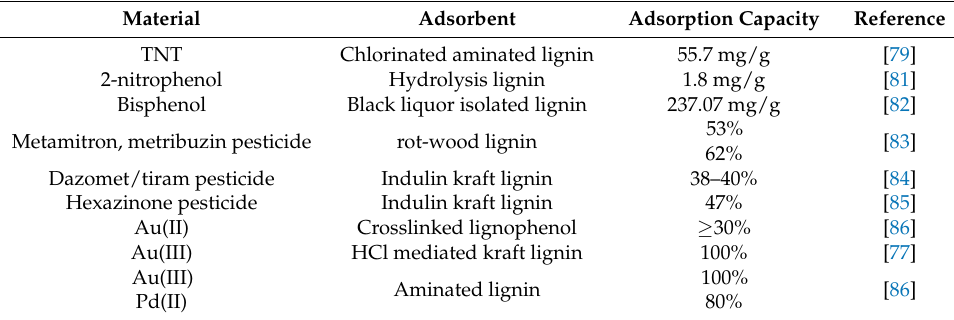
Table 5. Lignin as an adsorbent in other chemicals.